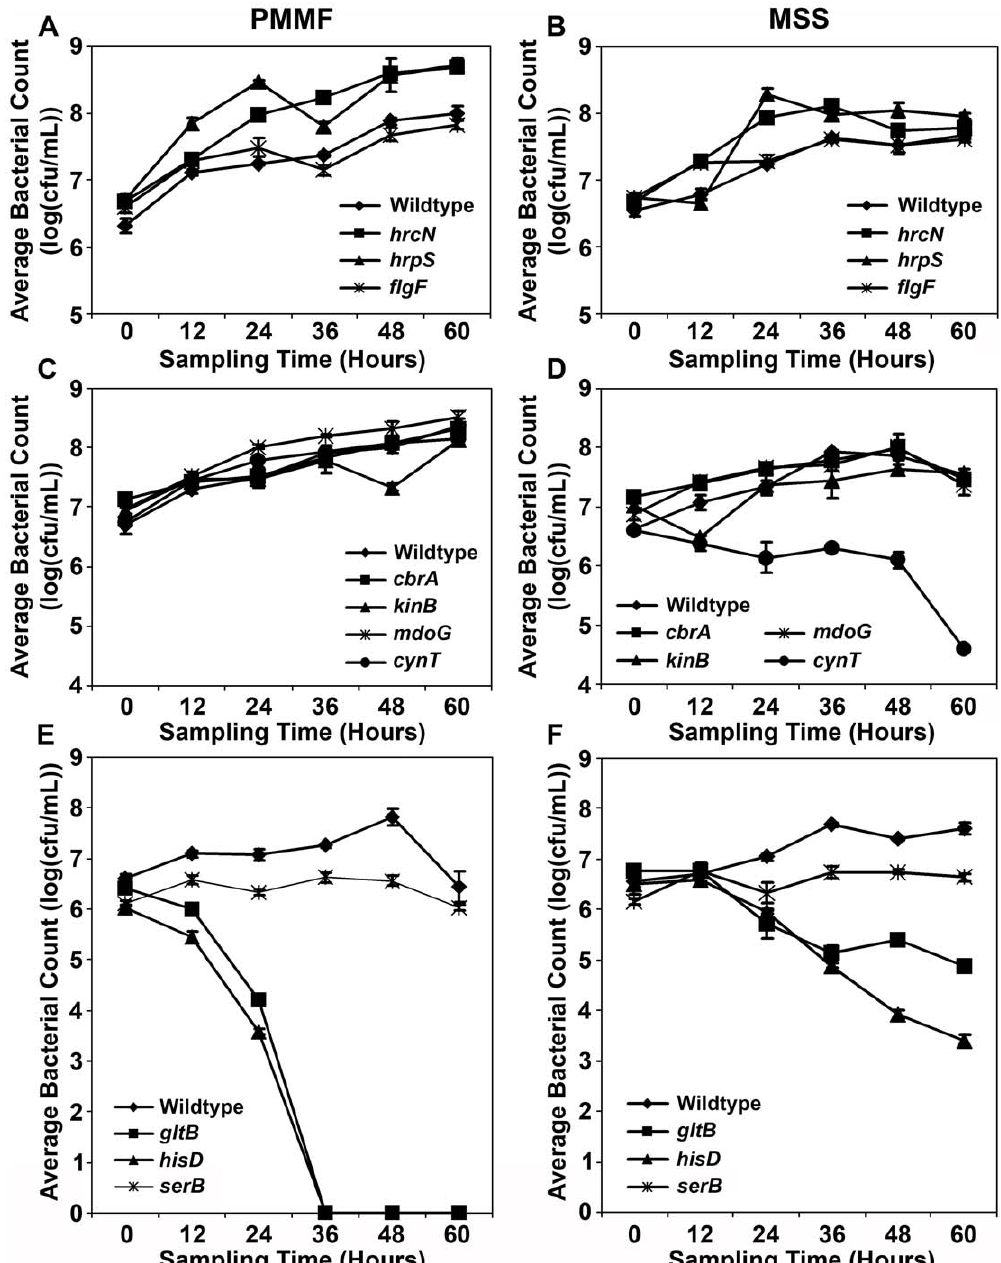
Figure 1. Invitro growth of Pma ES4326 transposon disruptants in Pseudomonas minimal media containing 10 mM fructose (PMMF) (A, C, E) or MS media in which Arabidopsis seedlings had been grown (MSS) (B, D, F). Cultures were adjusted to OD 600 =0.01 and incubated with shaking at 28 u C. Bacterial populations were quantified at 12-hour intervals by dilution plating. With the exception of wildtype Pma ES4326, genotype names indicate the gene that is disrupted by a mini-Tn 5 transposon. Error bars reflect standard deviation of the mean of four replicate samples. Three independent experiments were performed with similar results.